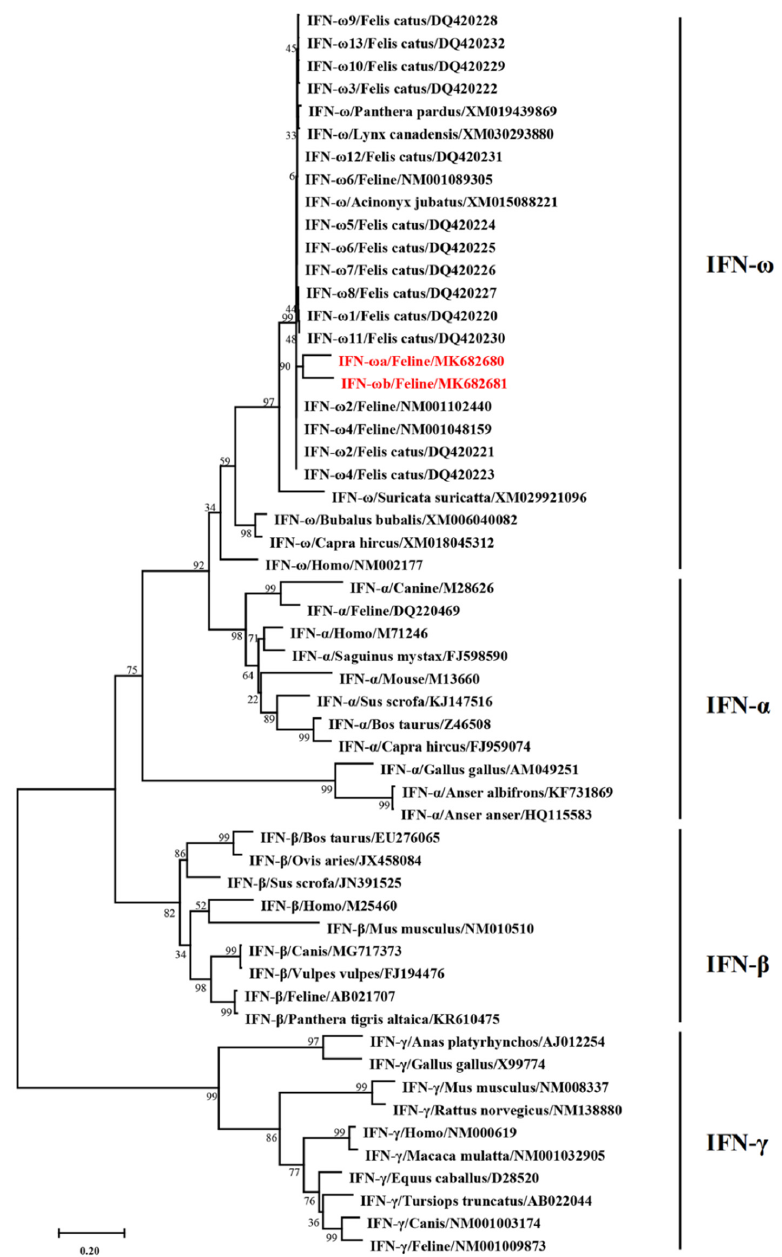
Figure 2. Phylogenetic analysis of nucleotide sequences of the feIFN- ω a and feIFN- ω b was performed with the maximum likelihood method using MEGA 7 software, compared with other IFNs found in cats and other animal species. The IFNs marked in red were cloned in this study.